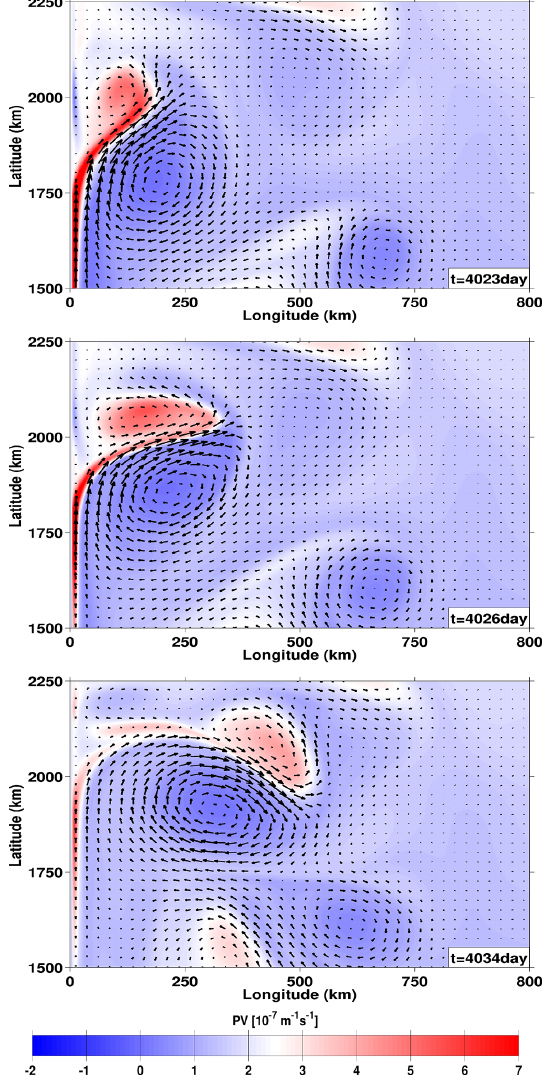
Figure 2. Sequence of potential vorticity (m − 1 s − 1 ) snapshots showing bursts and its subsequent development into a dipole for the lowest viscosity experiment (EXP300). From bottom to top, the snapshots were taken at t = 4023, 4026 and 4034